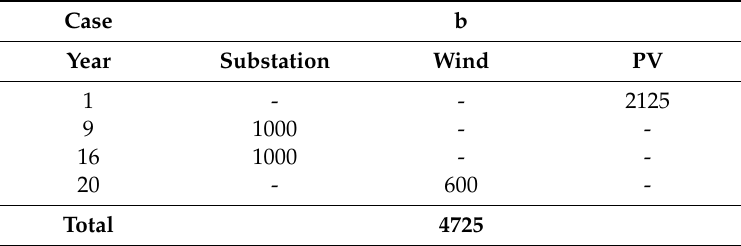
Table 7. Power installed (kW) in Case b.